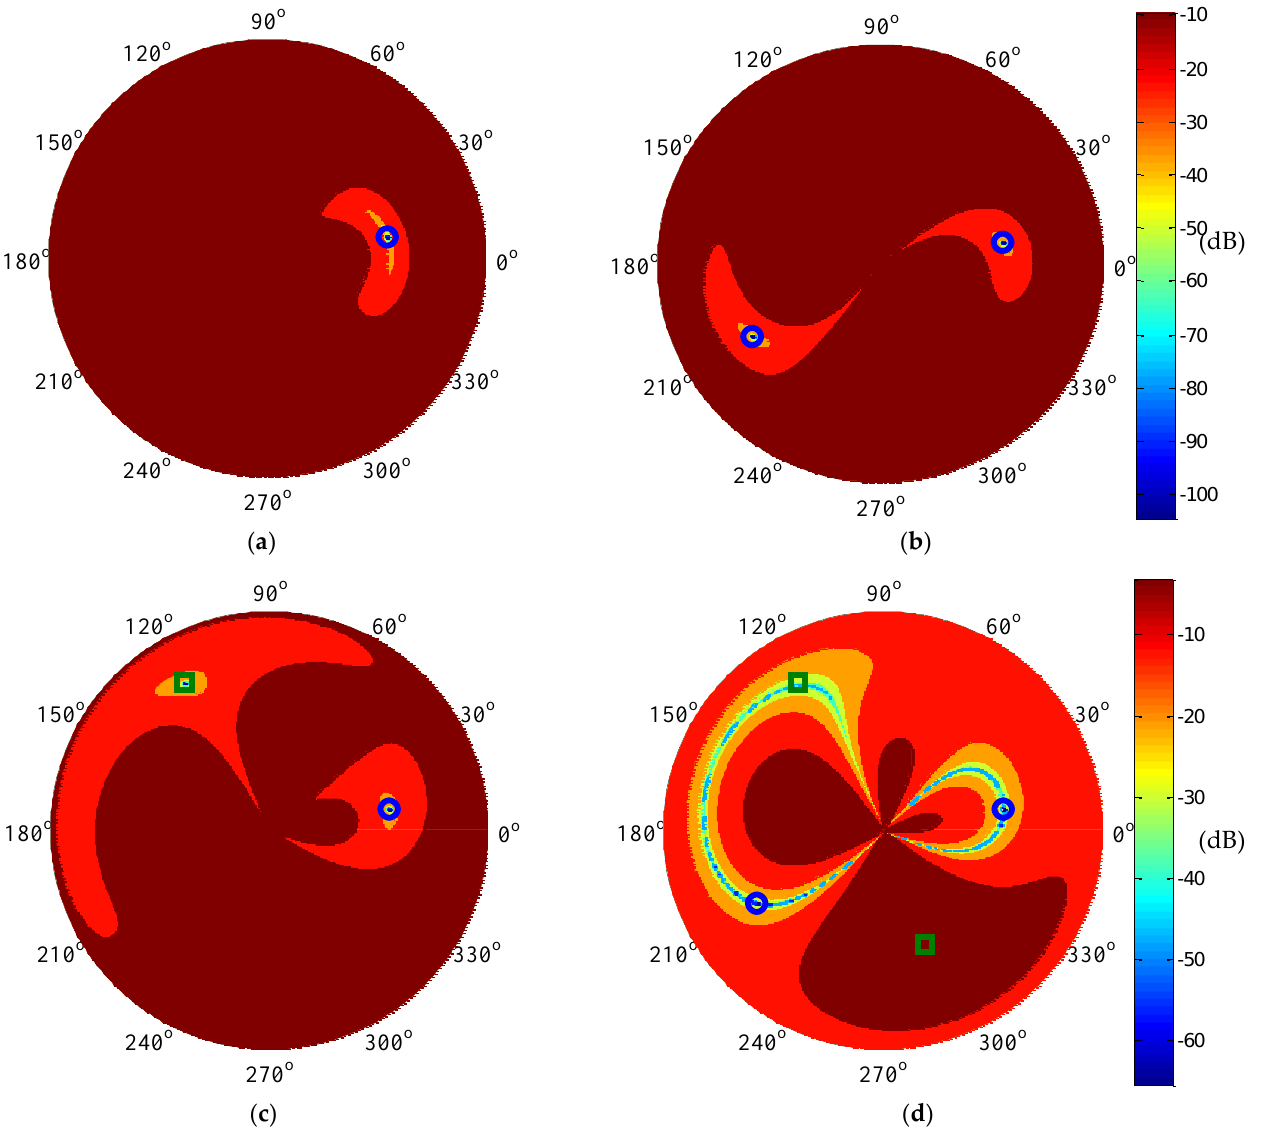
Figure 8. Array patterns in SOP: ( a ) one jammer without multipath, ( b ) two jammers without multipath, ( c ) one jammer with one multipath, and ( d ) two jammers with two multipaths. The four elements are adopted, so its DoF is 3, and it can suppress up to three interferences. In the above figure, when the total number of direct and multipath interference is less than three, the synthetic array can accurately form the null in the direct and multipath direction. In the case of two interferences with multipath, it is equivalent to the presence of four interferences from different directions, which is beyond the array DoF, so the direct and multipath interference cannot be effectively suppressed. In Figure 8d, there is a multipath in the direction of (290°, 40°), but the null is not formed in this direction on the pattern. The ICRs of the above four cases are shown in Table